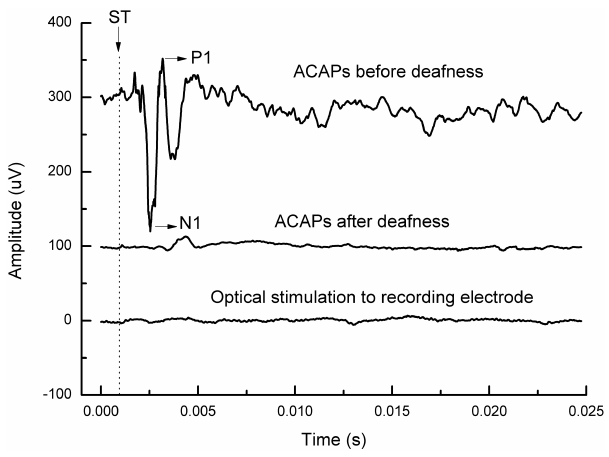
Fig. 3. ACAPs from the guinea pig before and after deafening surgery were measured with a tone burst by a speaker at 82 dB SPL and operated at a repetition rate of 0.5 Hz. The curve at the bottom is the signal through optical stimulation directly to the record electrode with black cloth covering the cochlear. ST stands for the starting time of stimulation.